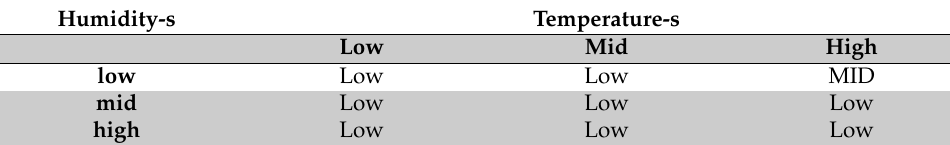
Table 6. Rules for SMDD (Short